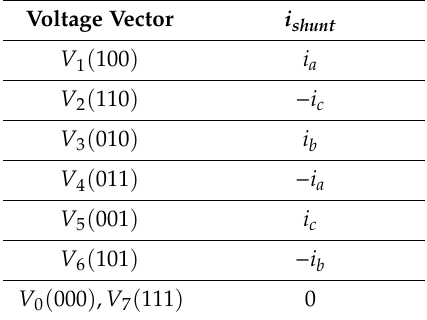
Figure 1. 1-shunt inverter with SPMSM. Table 1. DC link current according to voltage sectors.